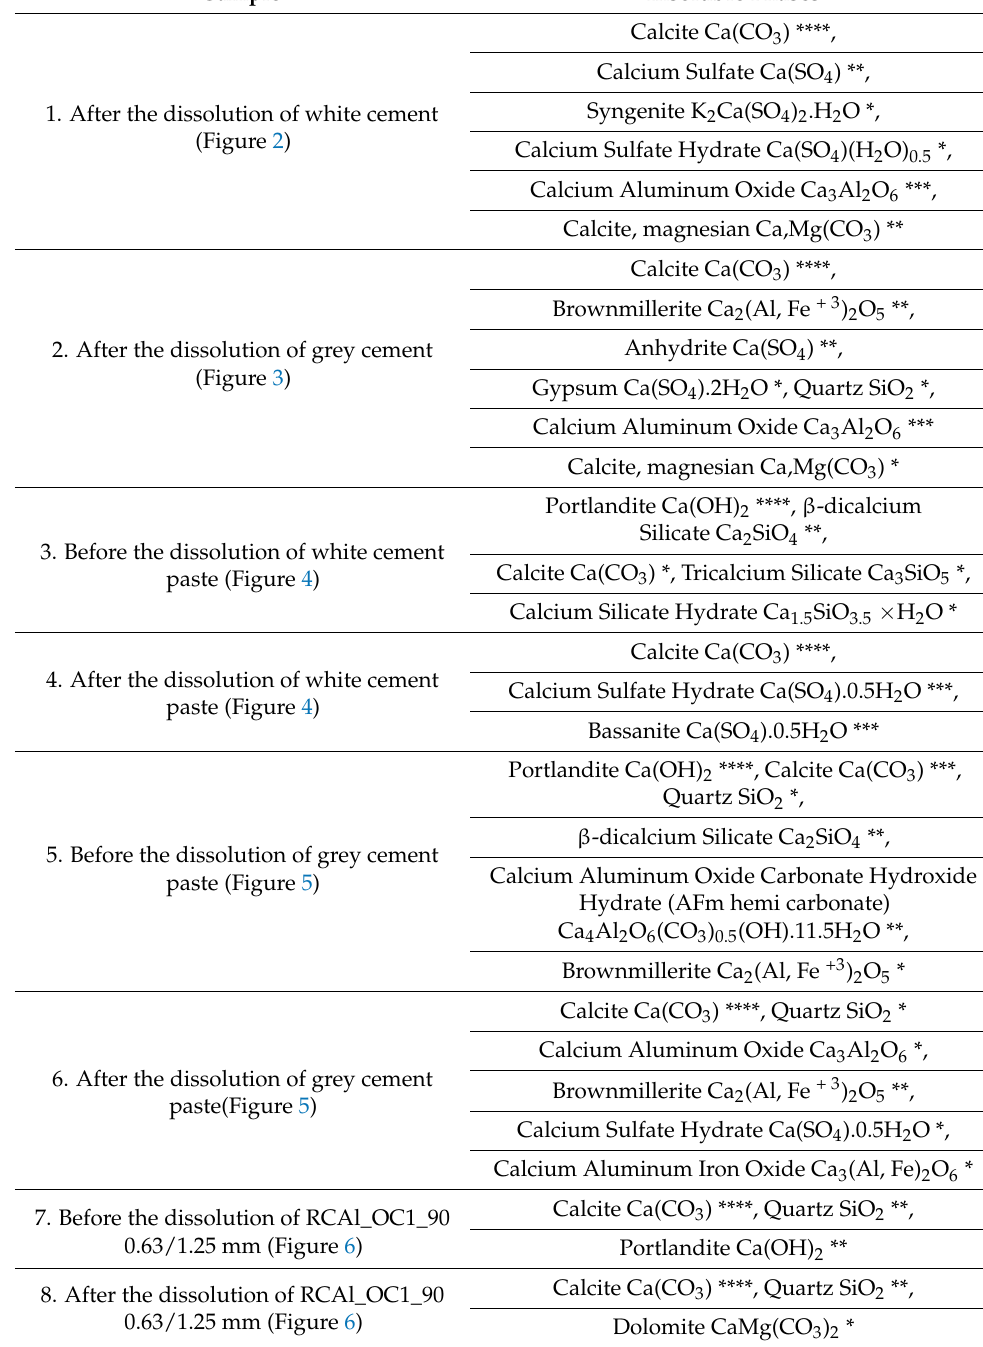
Table 3. XRD results before and after dissolution in salicylic acid and methanol for cement and pastes (number of * refers to the percentage of phases, the more *, the more percentage